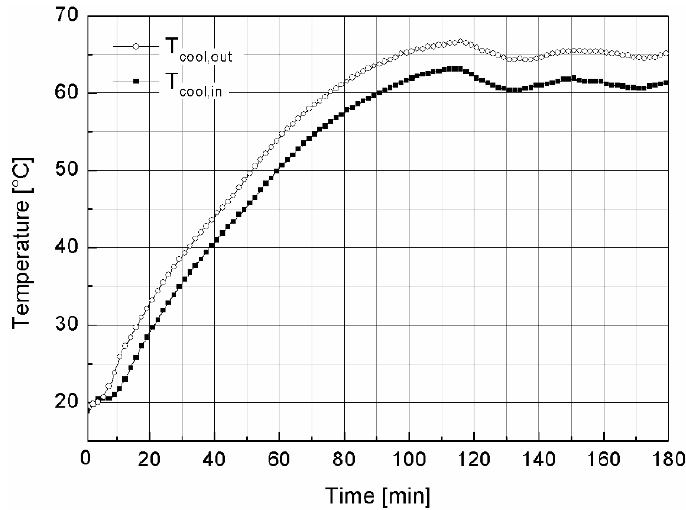
Figure 12. In- and outlet temperatures of the cooling